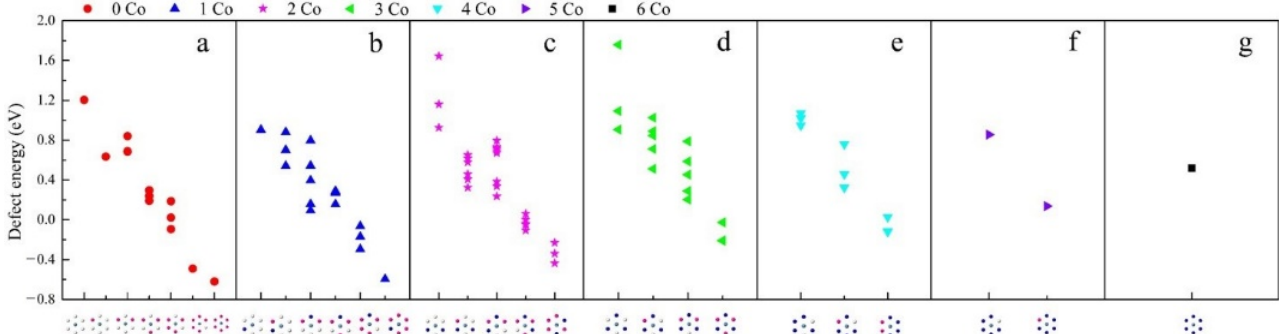
Figure 7. The defect energy of Li/Ni anti-site with different local coordination environments. From ( a – g ), the Co number of six local TM ions increases in turn. The Mn number increases from left to right under the same Co number.